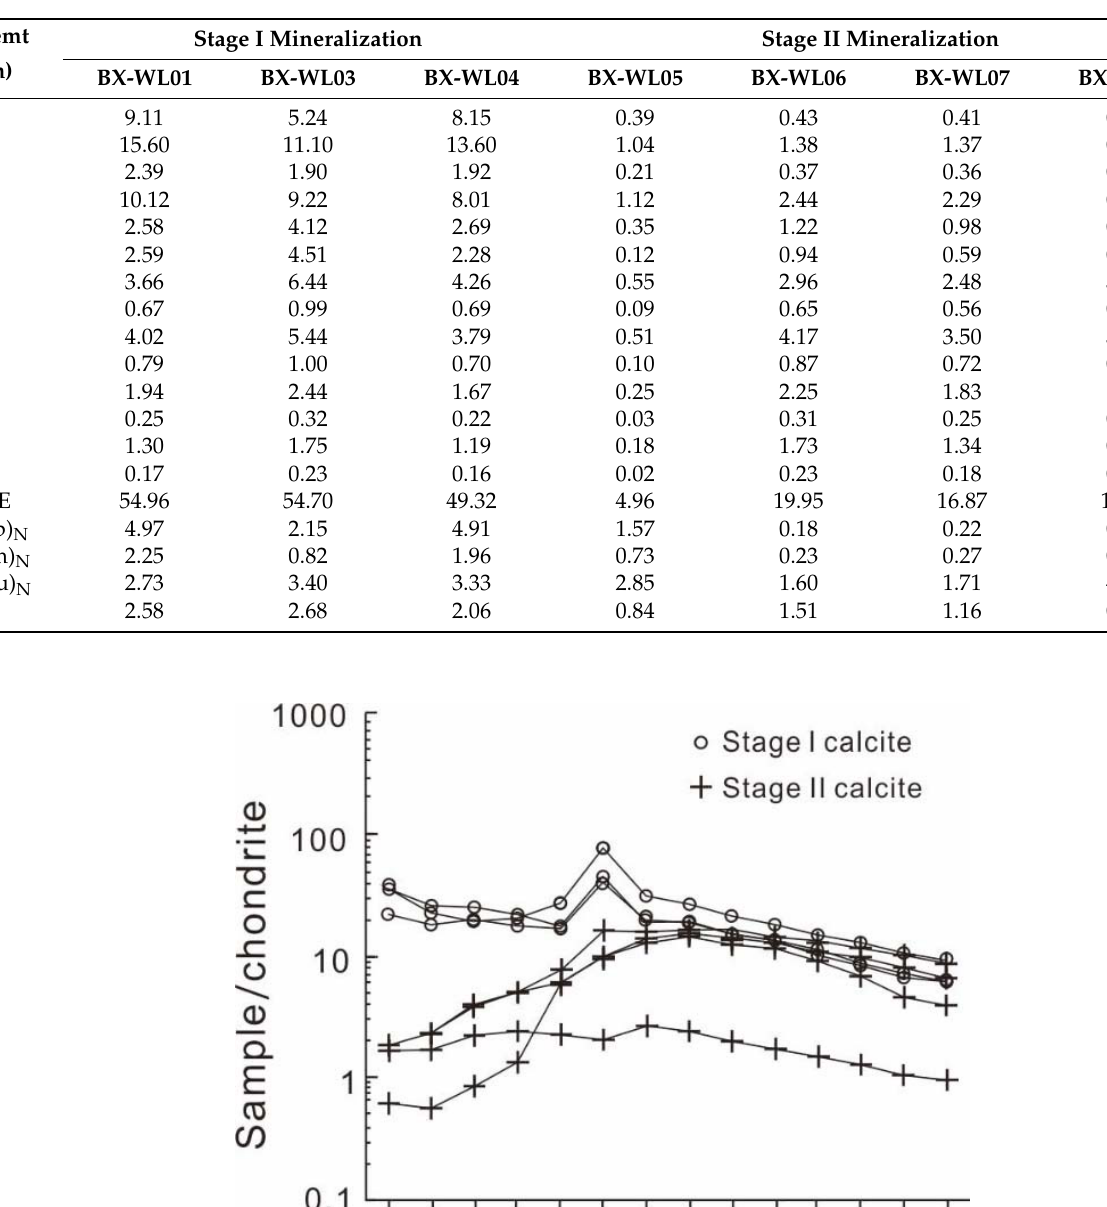
Table 5. Calcite REE concentration of early and second-stage mineralization from the Beixiang deposit.